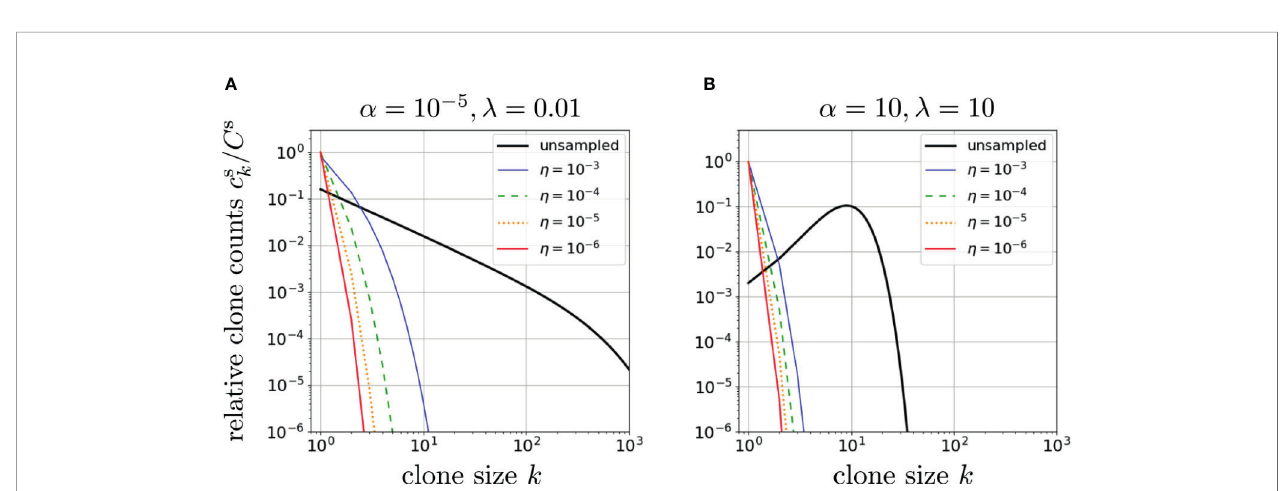
FIGURE 3 | The effects of sampling on two different neutral-model relative clone counts c s k = C s plotted using the dimensionless proliferation rate r = 1/2 in Eqs. 11 and 12 or Eq. 10 and S9 from Section 2 of the Supplementary Material . In (A) , we used a = 10 -5 , l =0.01. The effect of sampling is illustrated for h = 1 (no subsampling), 10 -3 , 10 -4 , 10 -5 , and 10 -6 . All clone counts are qualitatively similar, with subsampling increasing the exponential decay in c k . In (B) , we use a physiologically unrealistic set of parameters, a = l = 10, which leads to a qualitatively different unsampled clone count pattern that exhibits a peak. However, under small subsampling fractions h , the clone count loses its peak as it shifts to a rapidly decreasing patterns c s k that are not signi fi cantly different from sampled clone counts predicted using the parameters a and l in (A) . This indicates inferring parameters using clone counts is ill-conditioned (rather insensitive to parameters) if h is too